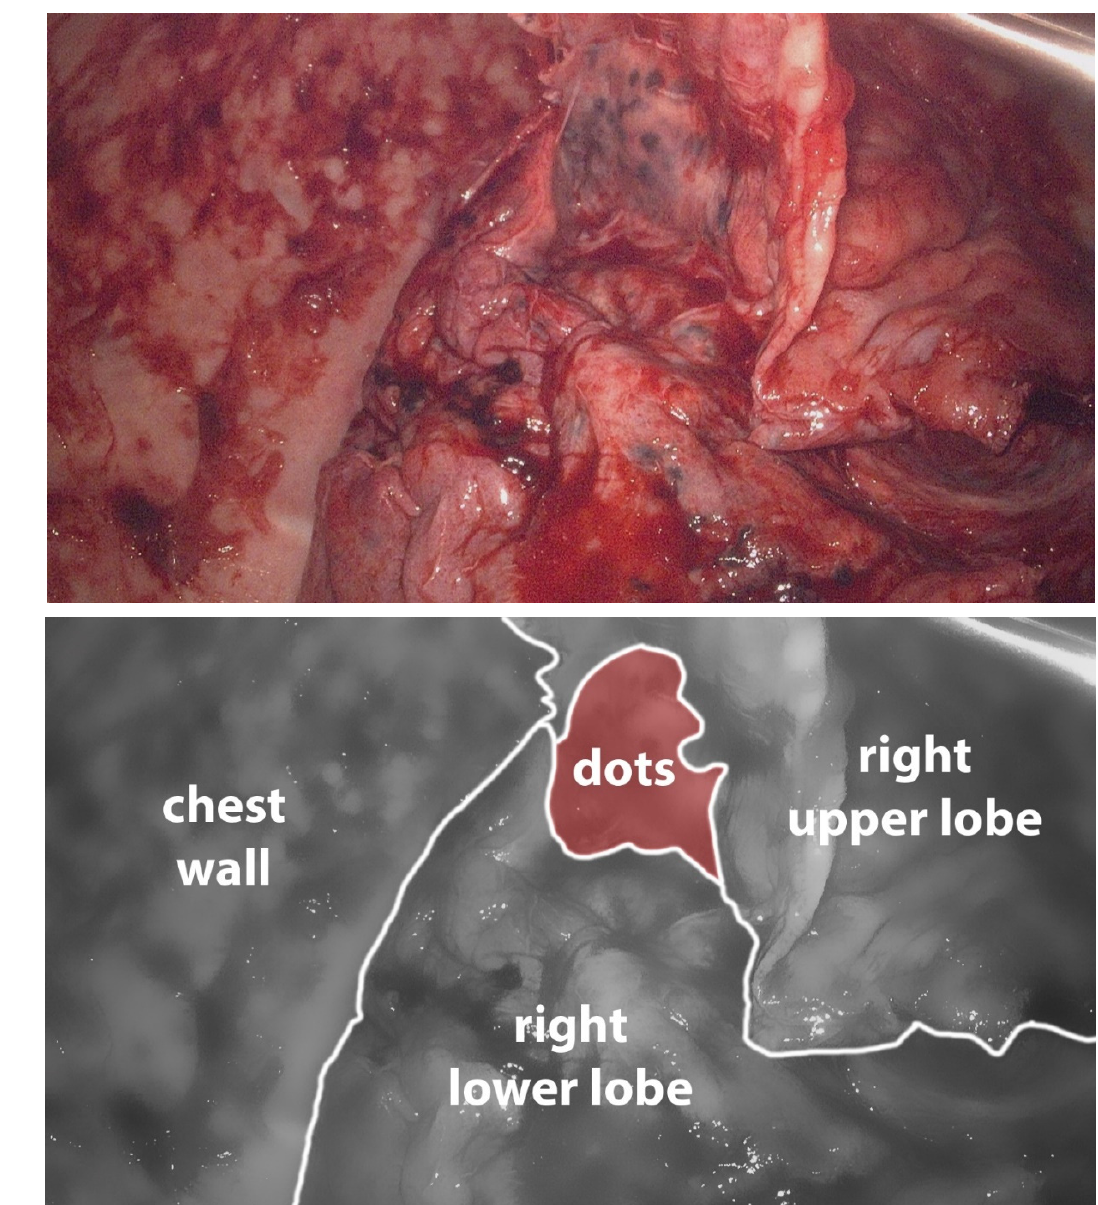
Figure 2. ( a ). Image taken during primary VATS decortication of the right lung. Lung tissue is covered with 2–3 mm black dots consistent with anthrasilicosis. Camera port in 8th intercostal space anteriorly, camera is looking in cranial direction. ( b ). Schematic representation of ( a ).